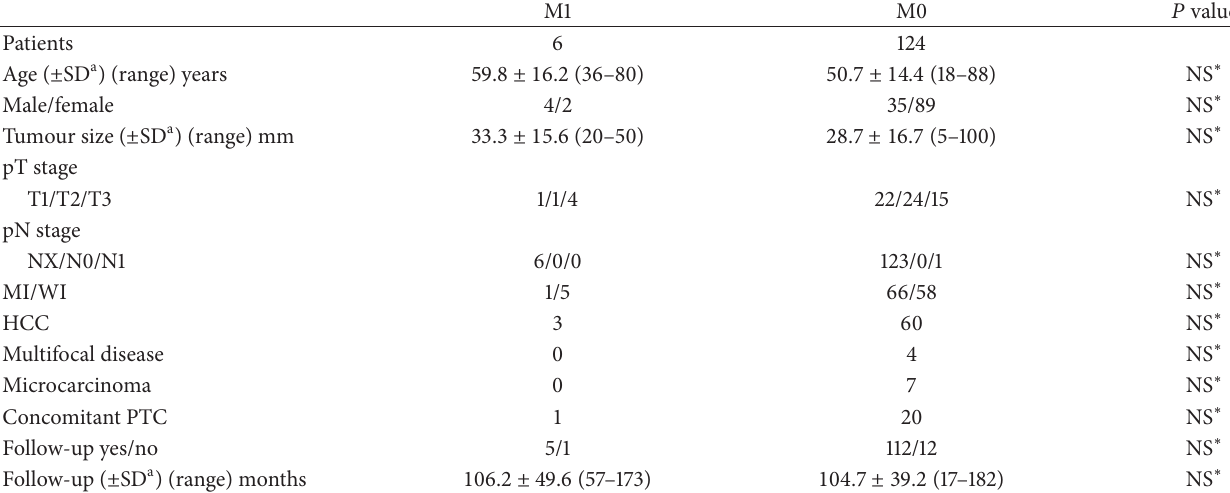
Table 3: M1 versus M0 patients: clinical, pathological, and follow-up